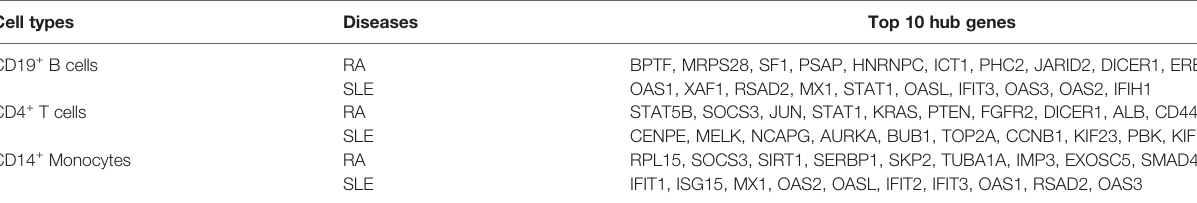
TABLE 2 | Top 10 hub gene of B cells, T cells and monocytes present in RA and SLE. Cell